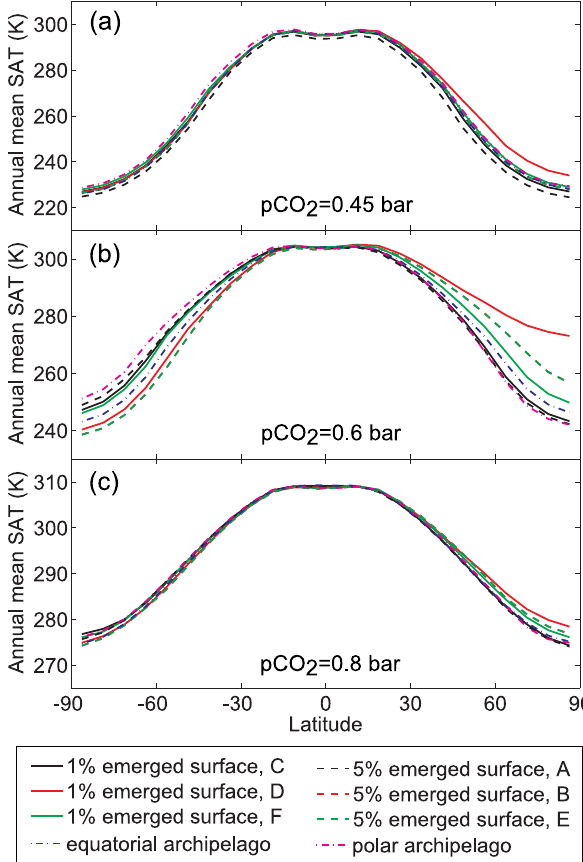
Fig. 18: SAT profiles corresponding to the set of 7 different early Archean topographies for (a) p CO 2 = 0.45 bar, (b) p CO 2 = 0.60 bar and (c) p CO 2 = 0.80 bar.